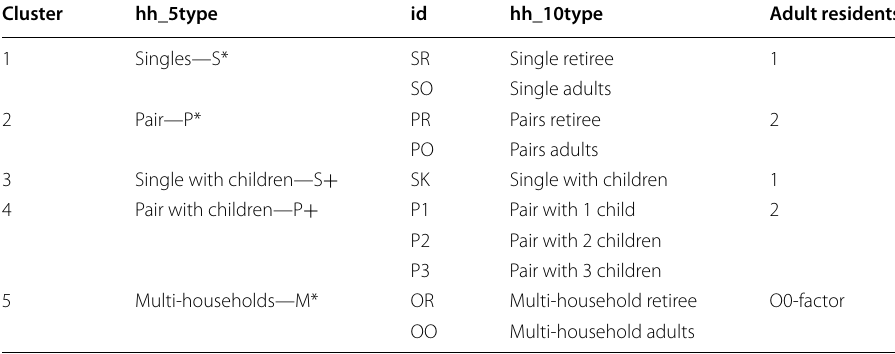
Table 1 HH type clusters and number of adult residents